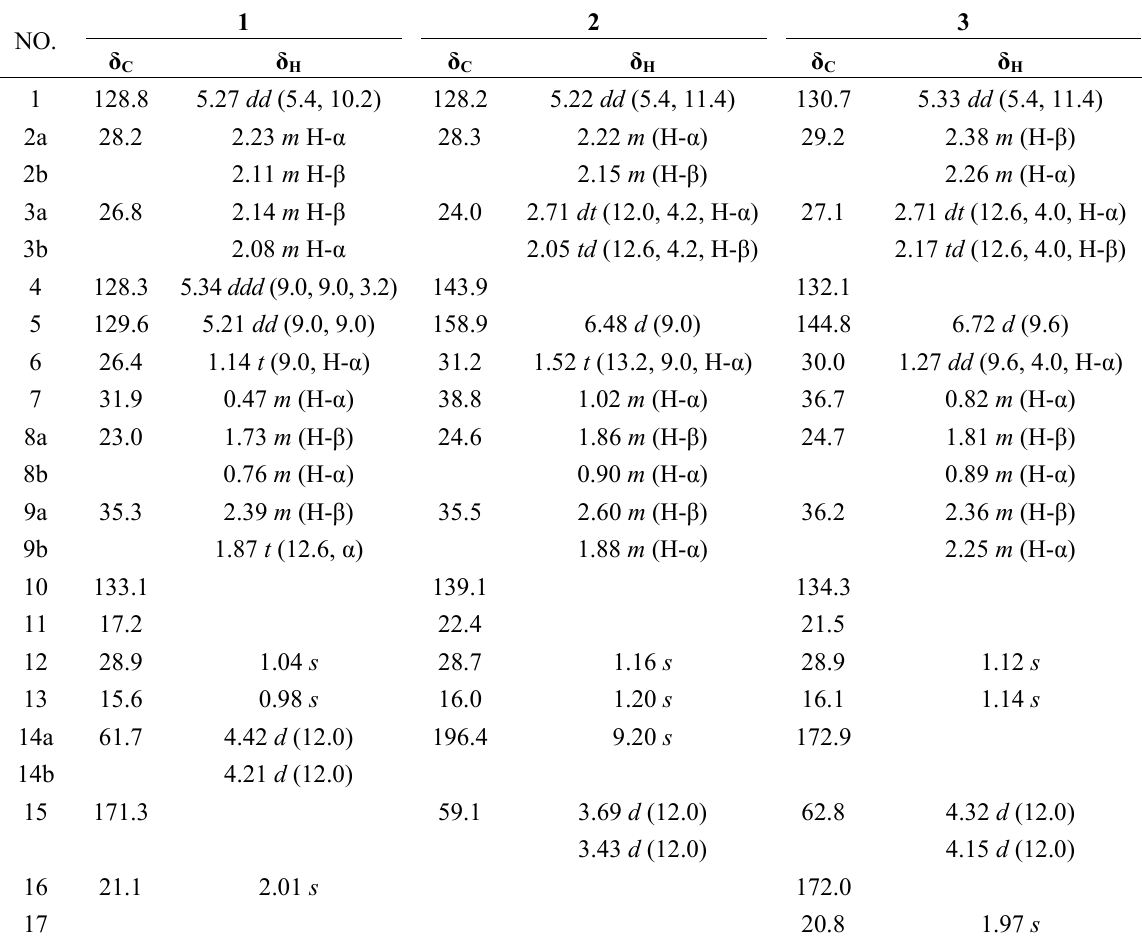
Table 1. 1 H and 13 C-NMR Spectroscopic Data of Compounds 1 – 3